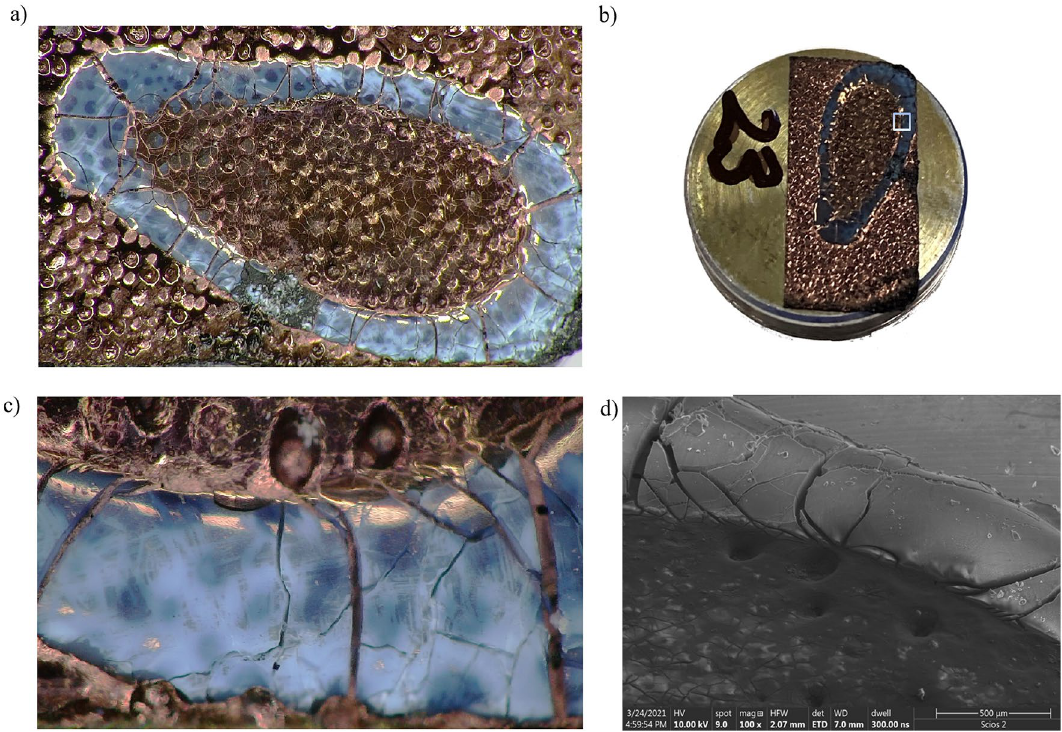
Figure 2. Photos of sample A : ( a ) image from optical microscopy; ( b ) macro image of the pin; ( c ) image from optical microscopy of the marked area; ( d ) SEM images of the edge of the sample—powder particles were found both on the edge and